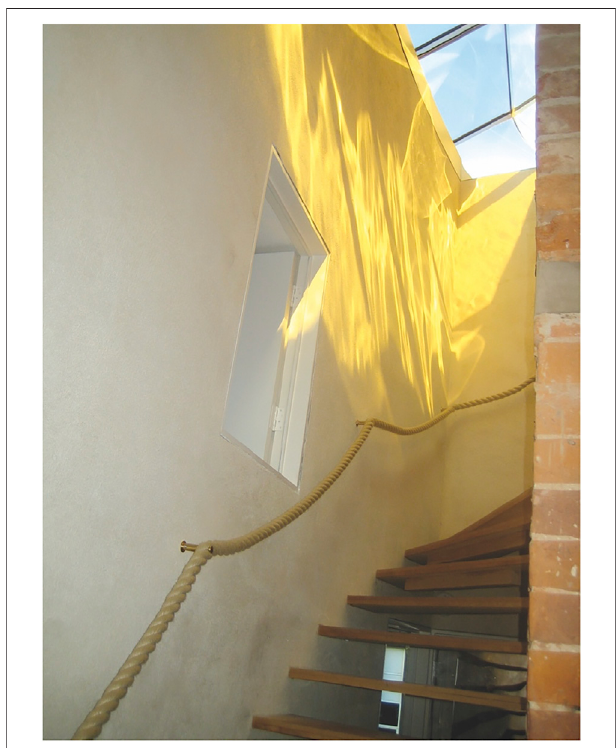
FIGURE 4 | High-level openable glazing above the stairs with daylight patterns (courtesy of John Christophers).